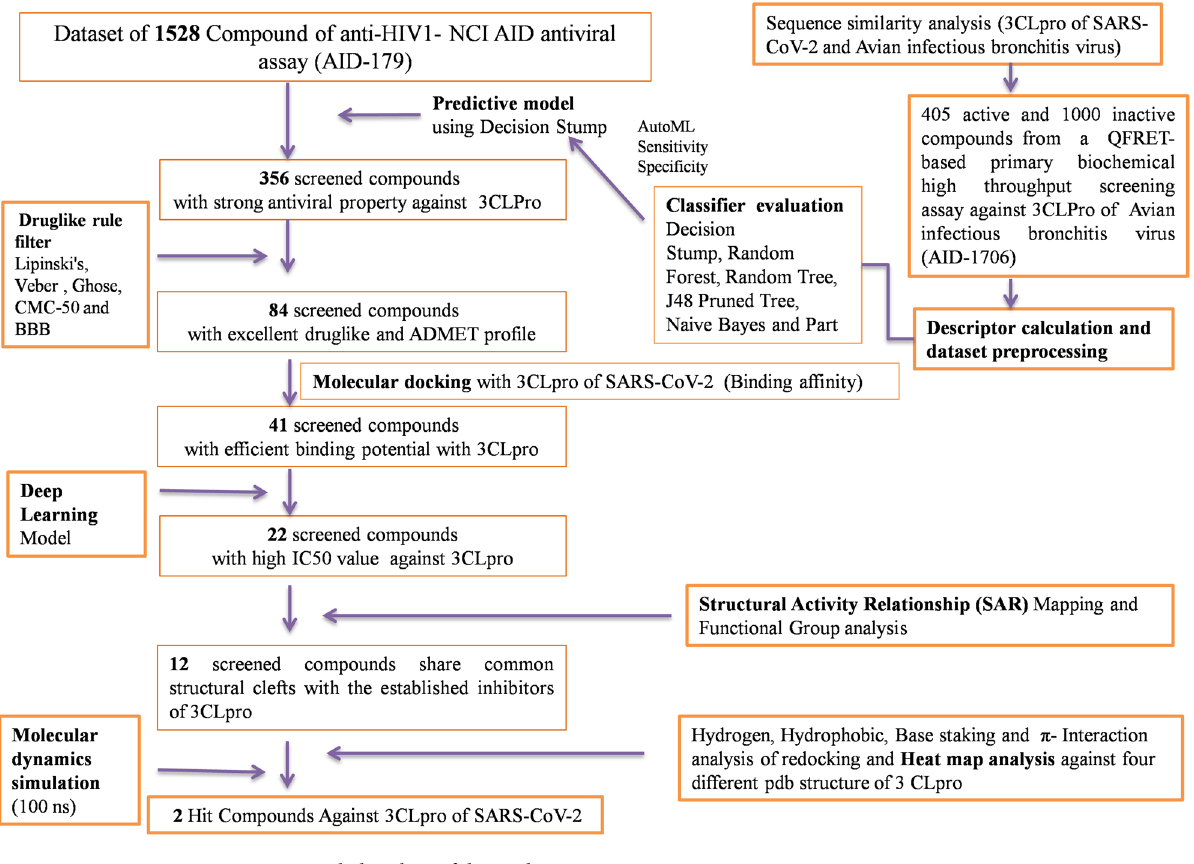
Figure 1. Detailed outline of the